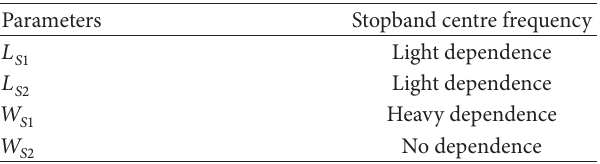
Table 1: The effects of H-shaped slot parametric variation on stopband centre frequency [17].